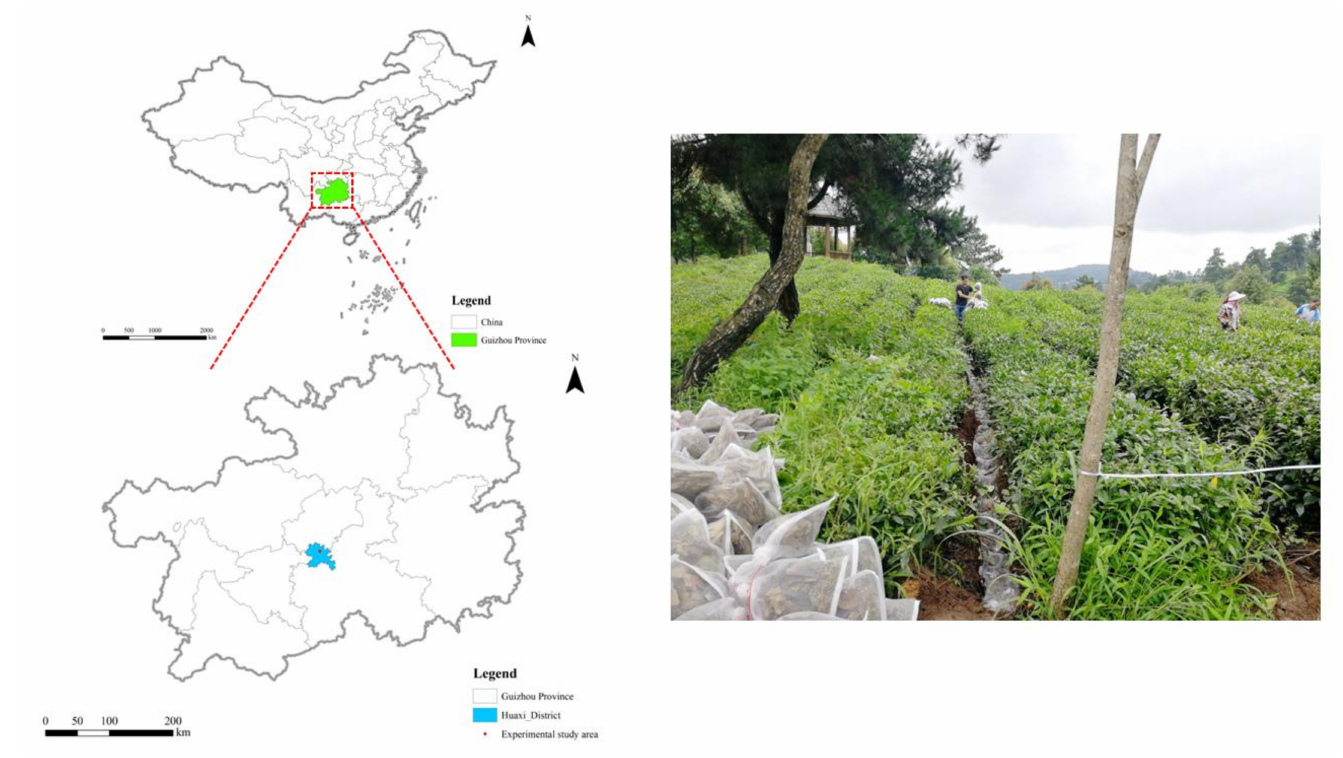
Figure 1. Experimental study area.